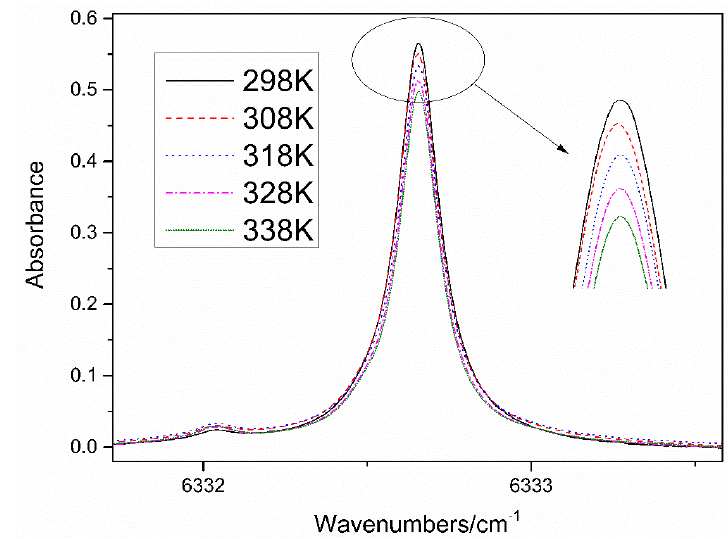
Figure 5. Absorption spectra of 16% CO 2 in the 6331.8 to 6333.6 cm − 1 spectral region at T = 298–338 K.